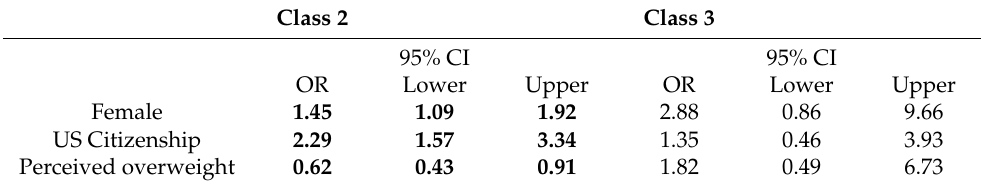
Table 3. Multinomial logistic regression using Class 1 as